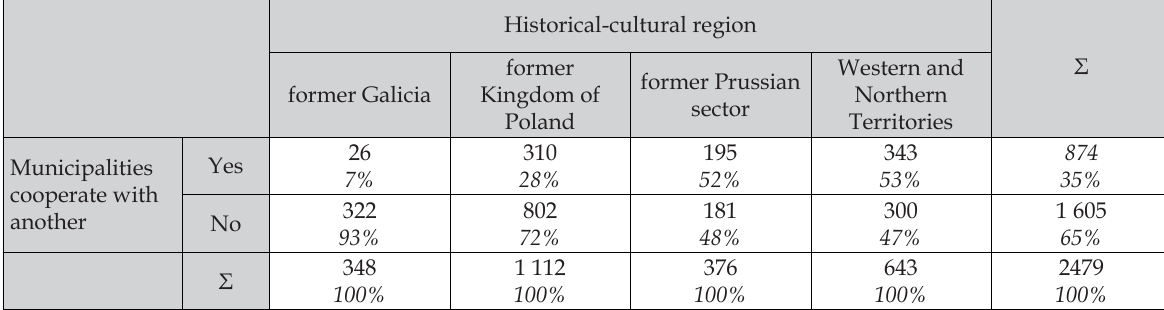
Table 2. Inter-municipal cooperation in waste management, by historical-cultural